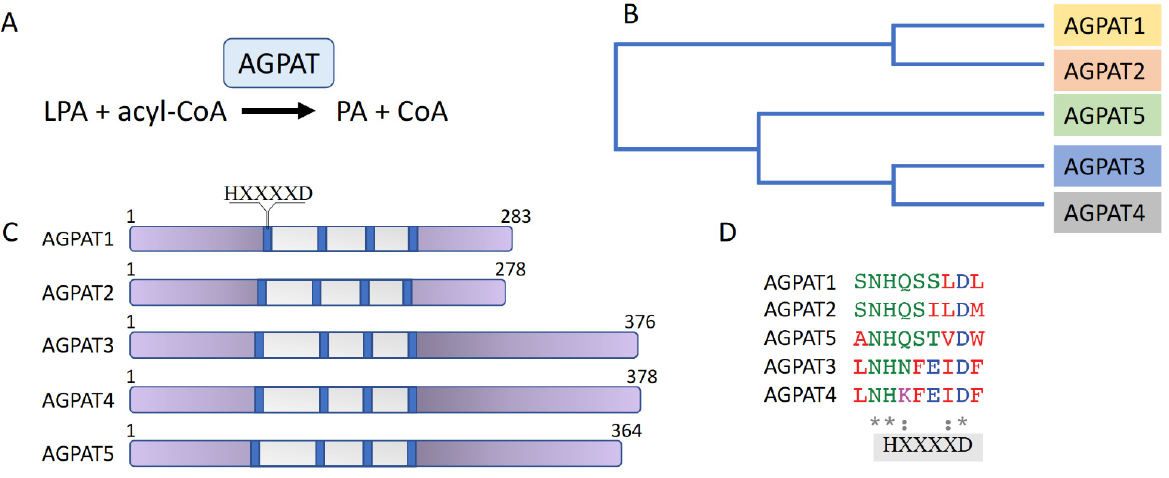
Figure 2. The AGPAT enzyme family. ( A ) AGPATs catalyze the conversion of LPA to PA. ( B ) Phylo- genetic tree of AGPAT1-5. ( C ) Schematic representation of AGPAT isoform domain structure. The acyltransferase region is shown in grey; the four acyltransferase motifs are shown in blue. The HXXXXD signature, conferring catalytic activity, is present in the first acyltransferase motif of all iso- forms. ( D ) Amino acid sequence alignment of the region containing the AGPAT isoforms’ HXXXXD signature. Conserved amino acids are marked by an asterisk